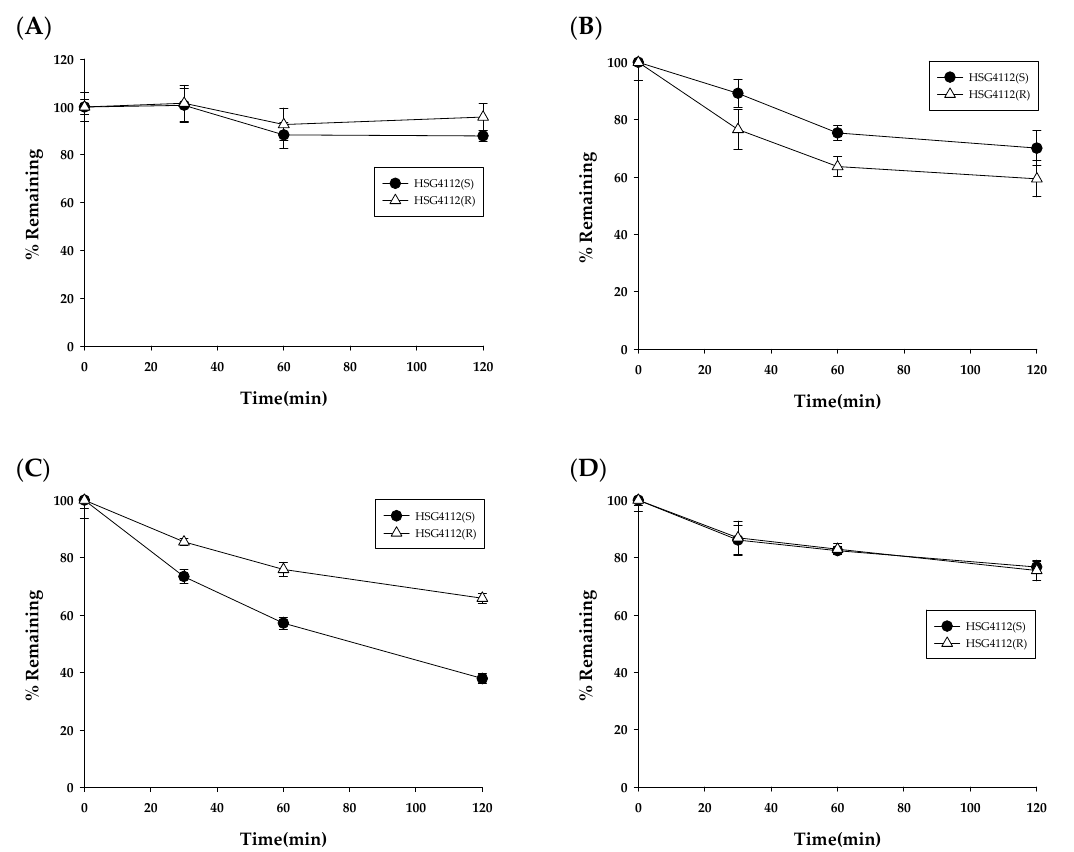
Figure 5. Metabolic stability of HSG4112 in ( A ) rat, ( B ) mouse, ( C ) dog, and ( D ) human intestinal microsomes ( n = 3).